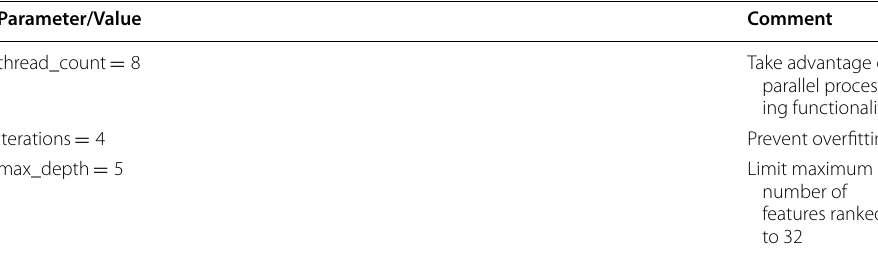
Table 6 Supervised ranking classifier CatBoost initialization